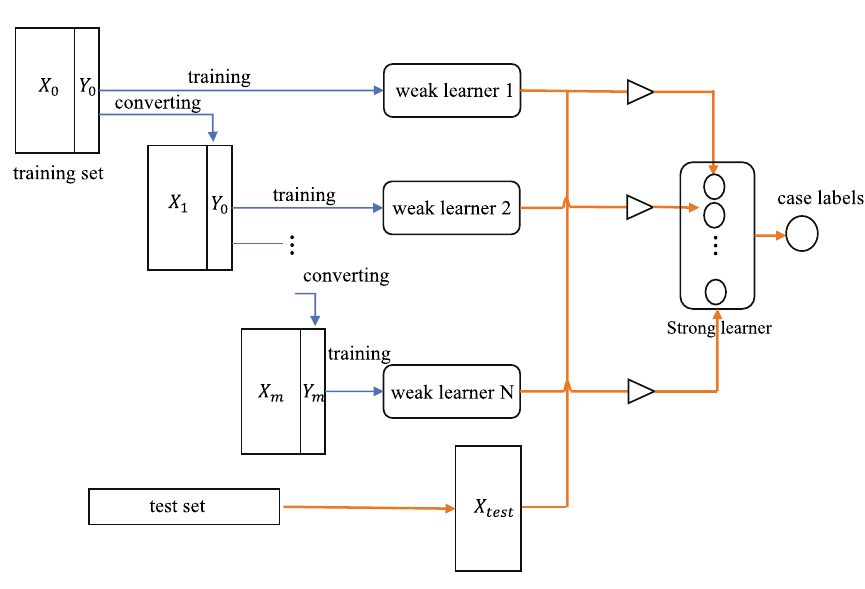
Fig. 2 Improved AdaBoost learning